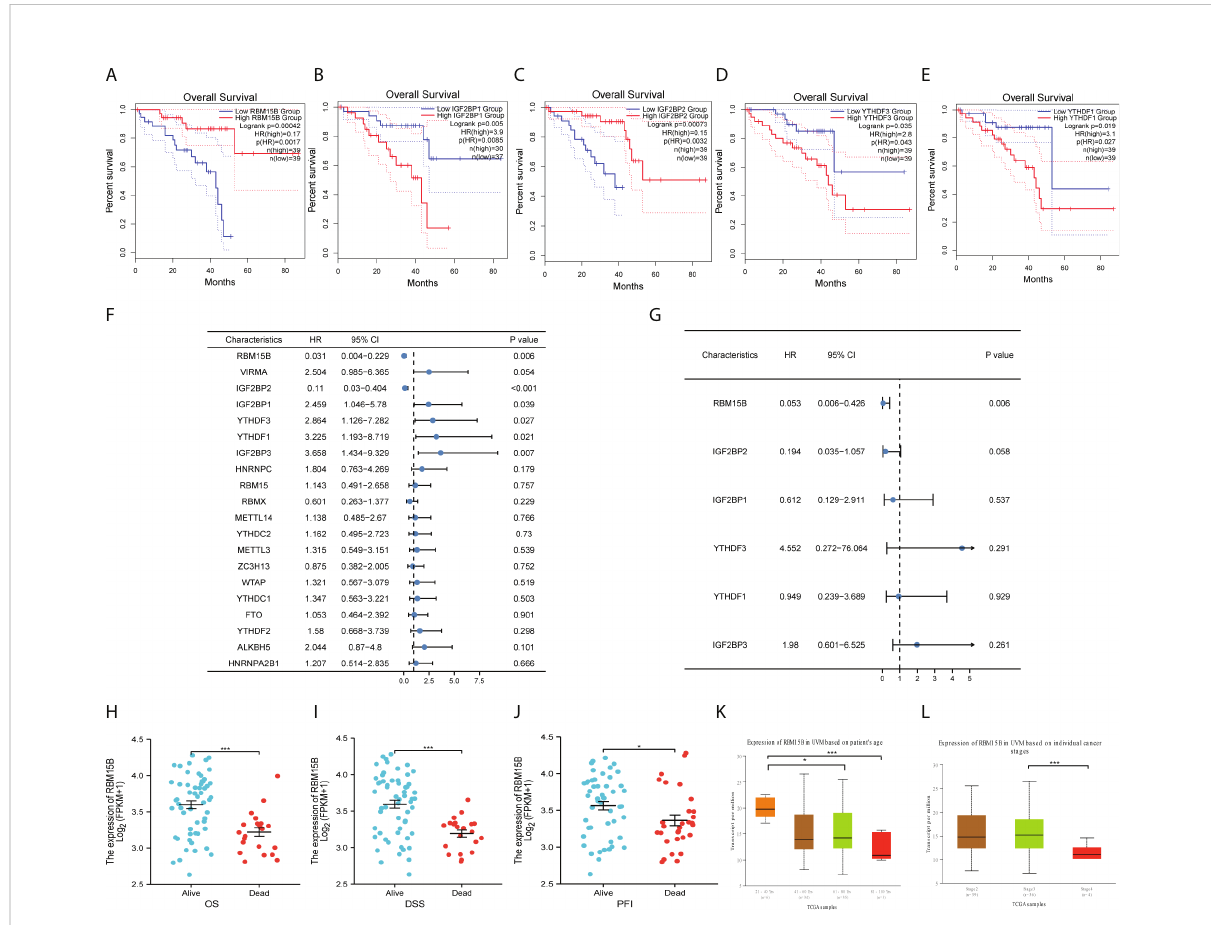
FIGURE 3 Identi fi cation of RBM15B as an independent prognostic biomarker and its correlation with clinical characteristics. Overall survivals of UM patients were calculated by Kaplan-Meier curves based on different expression of (A) RBM15B , (B) IGF2BP1 , (C) IGF2BP2 , (D) YTHDF3 and (E) YTHDF1 . (F) Univariate cox regression analysis and (G) Multivariate cox regression analysis of m 6 A regulators. RBM15B expression was signi fi cantly correlated with (H) OS, (I) DSS, (J) PFI, (K) Age and (L) Cancer stage. *p<0.05, ***p<0.001. OS, overall survival. DSS, disease speci fi c survival. PFI, progression free